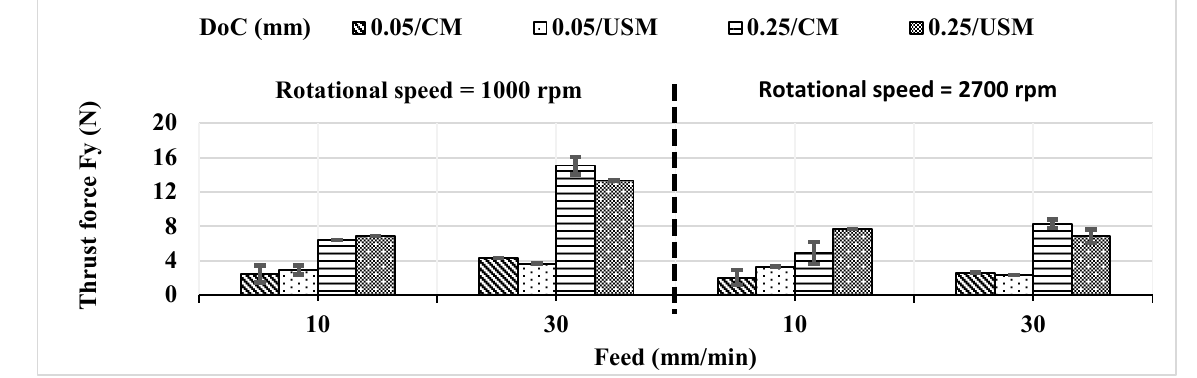
Figure 19. Cutting force (Fy) in thrust feed direction at different cutting parameters.